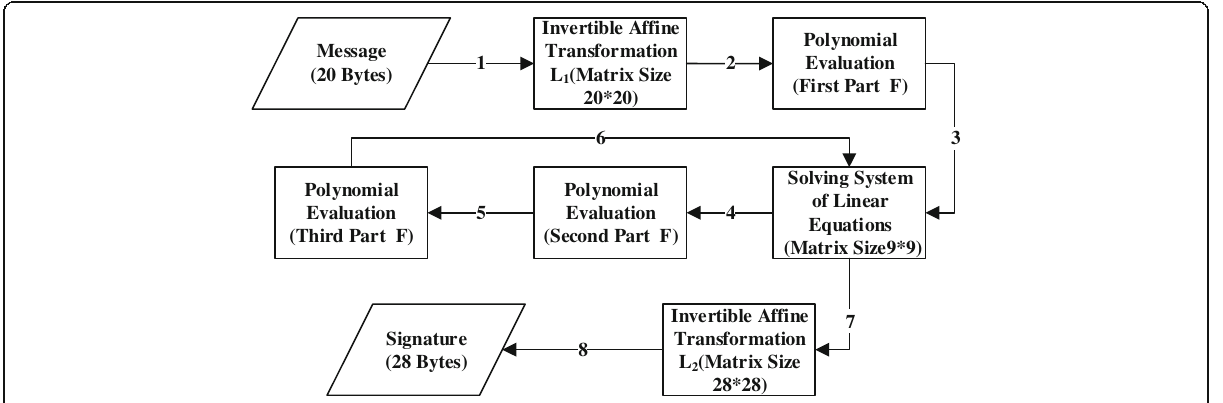
Fig. 1 The generation process of multivariate